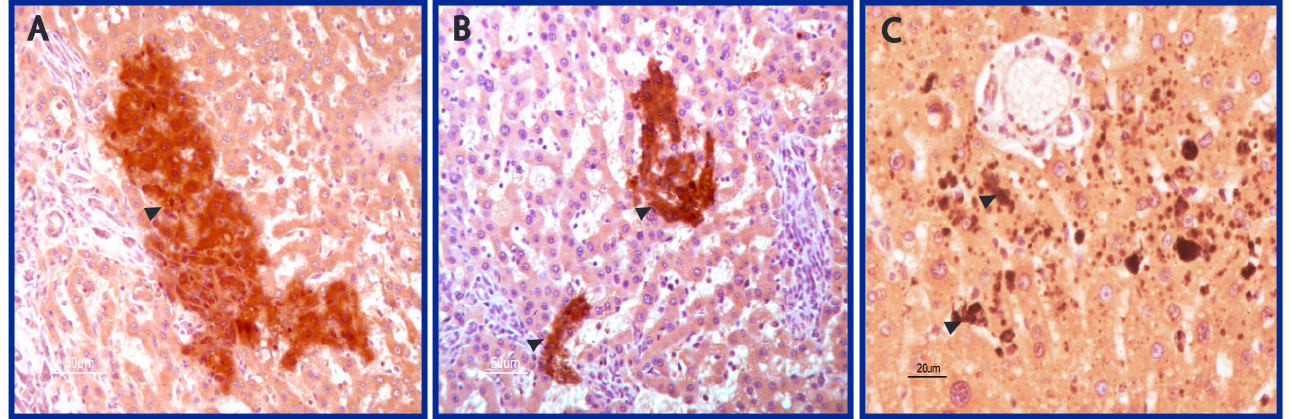
Figure 3. AFB1 staining in rat HCCs. ( A – C ). Strong AFB1 staining of neoplastic clusters and tumor-infiltrating cells in rat HCCs. Scale bars are reported. Magnification: ( A , B ): 20×; ( C ): 40×.